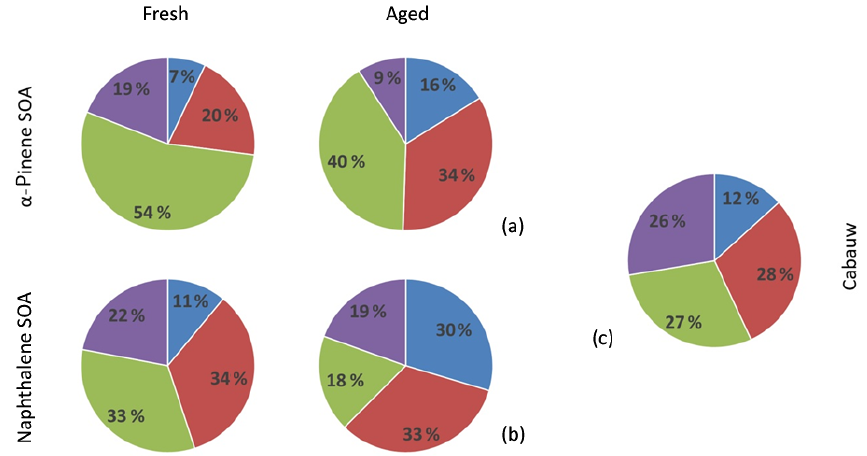
Figure 8. Distribution of HPLC fractions (total recovered TOC content = 100%) for α -pinene SOA (a) , naphthalene (b) , and for ambient OA sampled in Cabauw, Netherlands (c) .